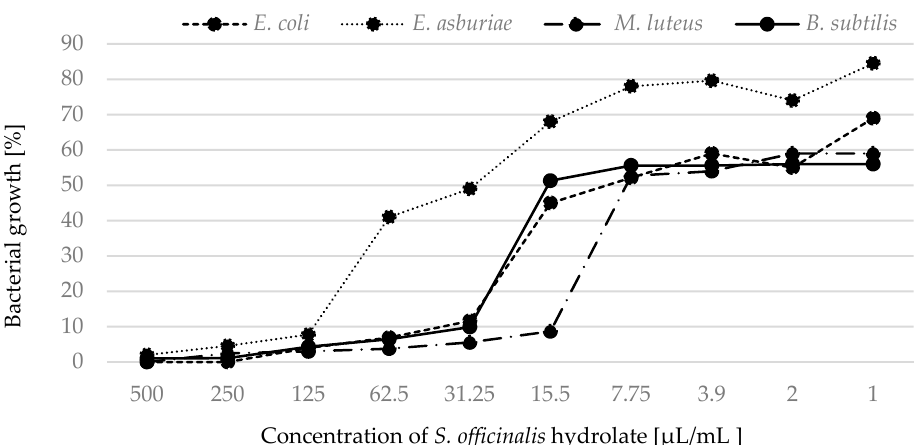
Figure 2. The growth of bacterial strains in the presence of S. officinalis hydrolate.